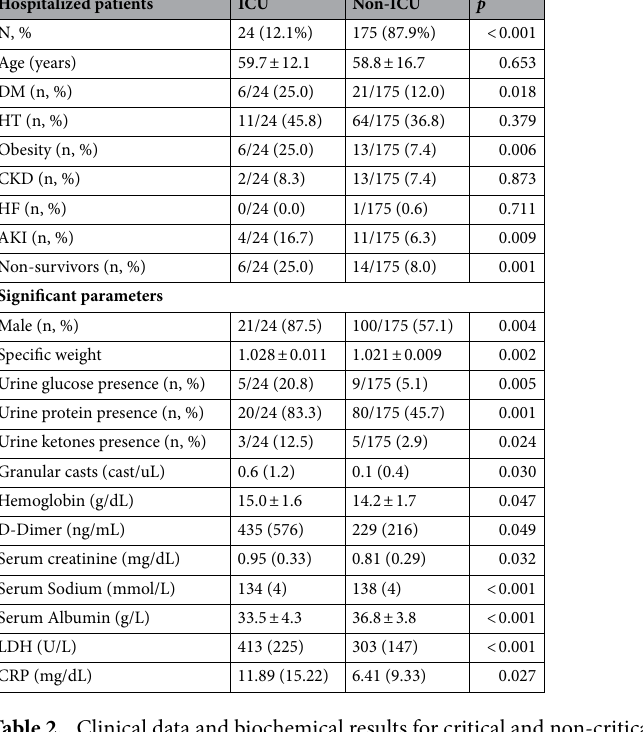
Table 2. Clinical data and biochemical results for critical and non-critical COVID-19 patients. Quantitative variables were described by mean ± standard deviation or median (IQR); DM, Diabetes; HT, Hypertension; CKD, Chronic kidney disease; HF, heart failure; ICU, Intensive Care Unit; AKI, Acute Kidney Injury; LDH, lactate dehydrogenase; CRP, C-reactive